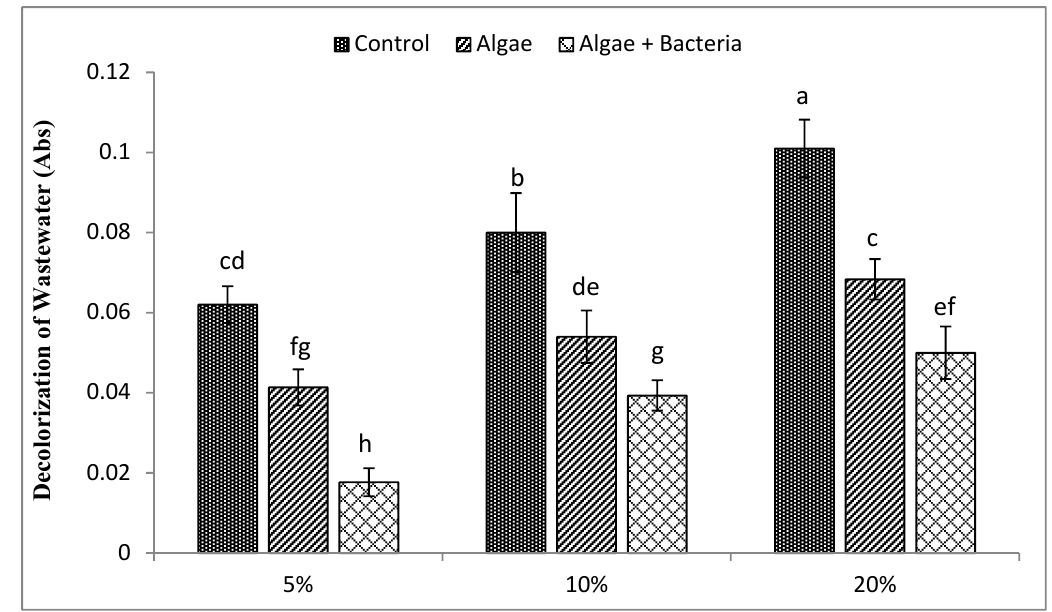
Figure 2. Efficiency of algae and algal–bacterial consortium for decolorization of textile industry wastewater with respect to their control values at different dilution levels. Columns show mean values and bars show standard deviation (SD) of means. All means followed by different letters were significantly different according to Tukey HSD (honestly significant difference) test at p < 0.05.